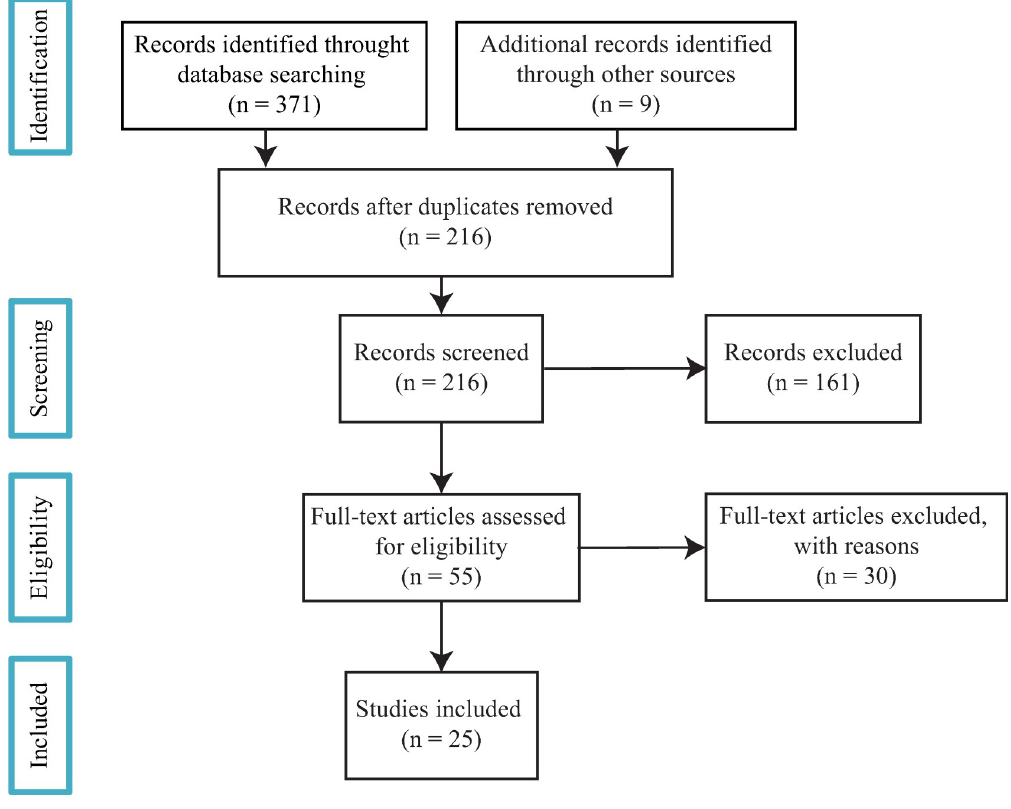
Fig 1. Flowchart of selection